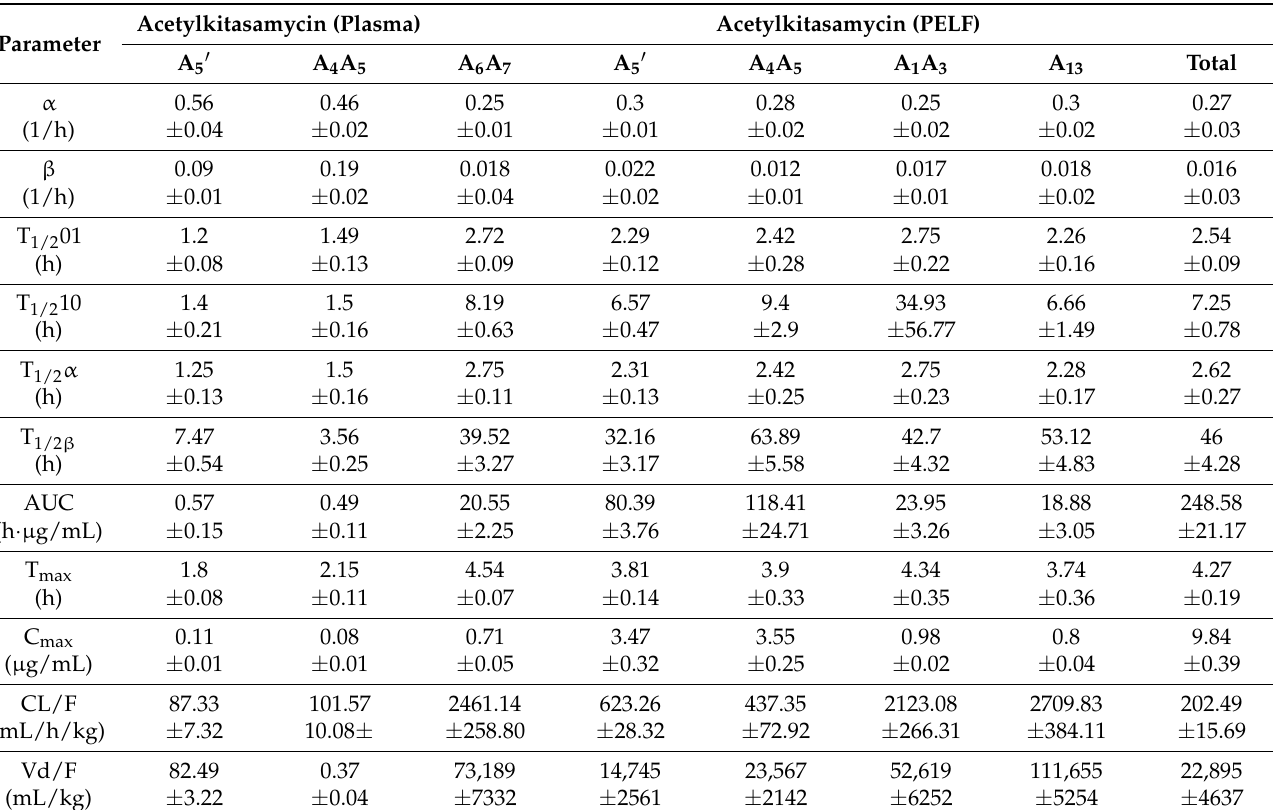
Table 5. PK of acetylkitasamycin and every component in plasma and PELF after intragastric administration ( n =